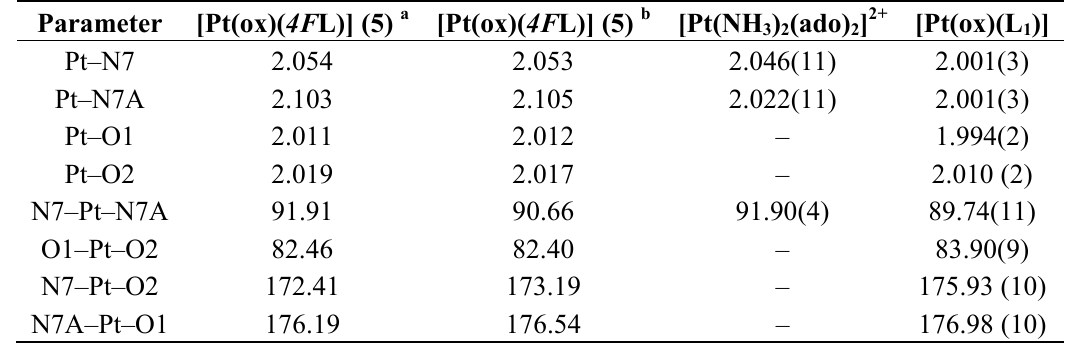
) (ado) ](ClO ) ·3.5H O 3 2 2 4 2 2 )]·2DMF (L = 2-chloro- N 6-(2,4-dimethoxybenzyl)- 1 1